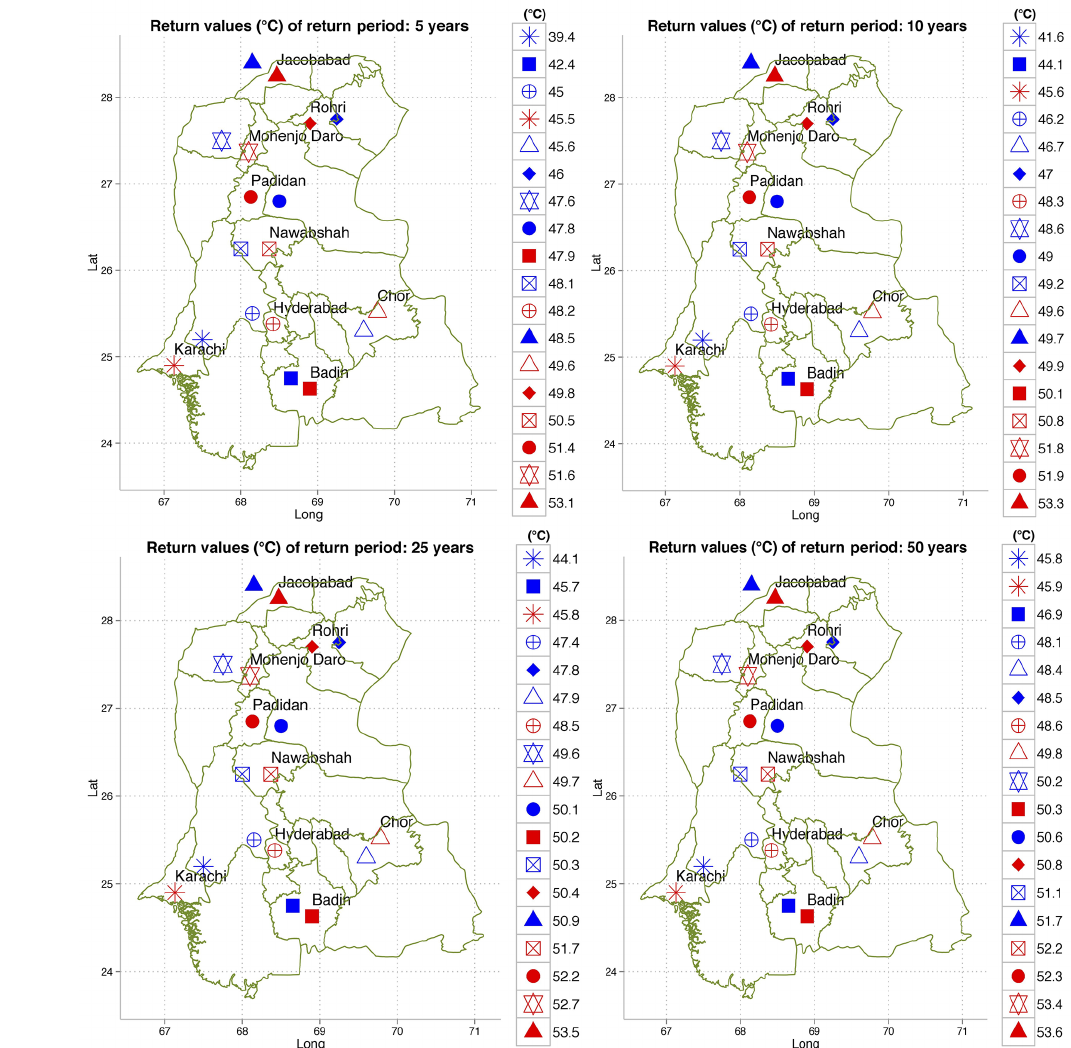
Figure 8. Spatial distribution of the station-observed T max (red) and bias-corrected ERA-Interim T max (blue) return levels in degrees Celsius corresponding to return periods of 5, 10, 25, and 50 years in southern